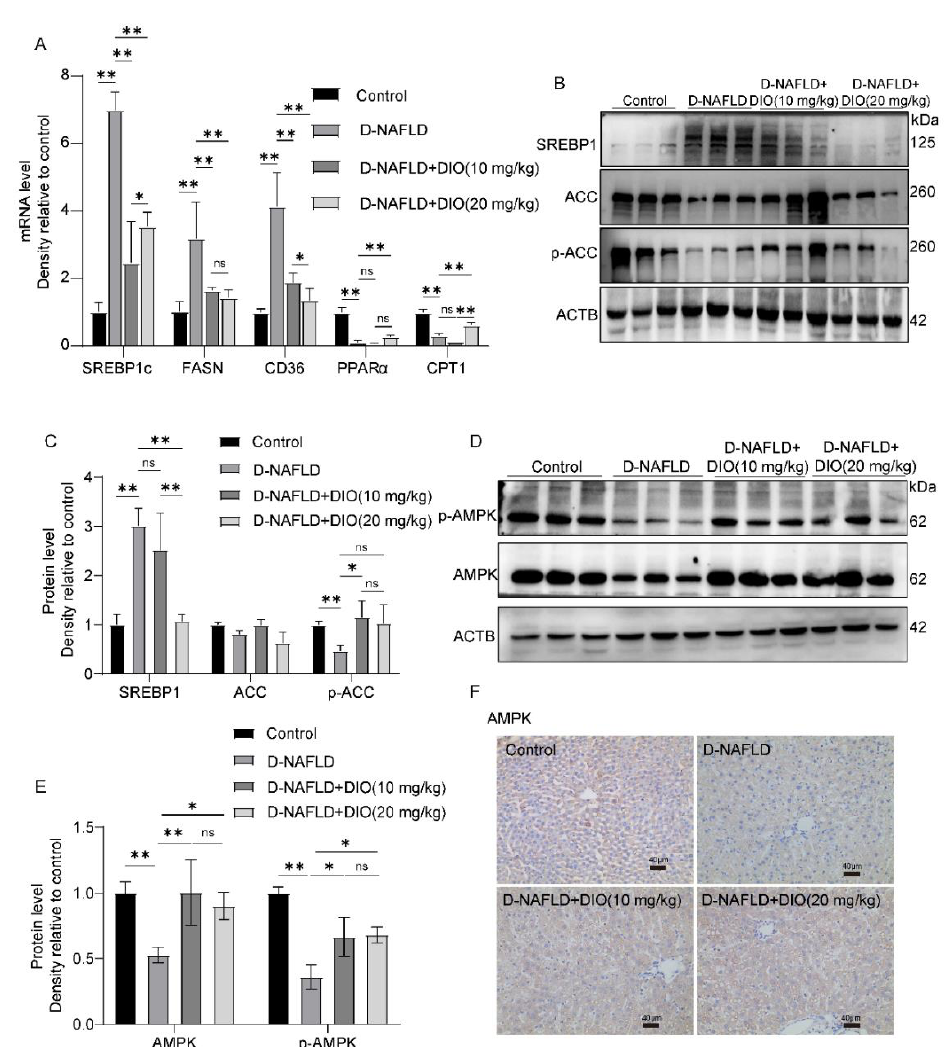
Figure 4. DIO inhibited hepatic steatosis through the regulation of AMPK-ACC/SREBP1 pathway. ( A ) The mRNA expressions of SREBP1c , FASN , CD36 , PPAR α , and CPT1 . ( B ) Western blot images of SREBP1, ACC, p-ACC, and ACTB. ( C ) Relative protein expressions of SREBP1, ACC, and p-ACC. ( D ) Western blot images of p-AMPK, AMPK, and ACTB. ( E ) Relative protein expressions of AMPK and p-AMPK. ( F ) The images of AMPK immunohistochemistry, × 100, scale bars = 40 µ m. Data in ( A ) ( n = 5) and data in ( B – F ) ( n = 3) were presented as mean ± SD. ns indicates no significance, * and ** indicate significant difference and highly significant difference, respectively.